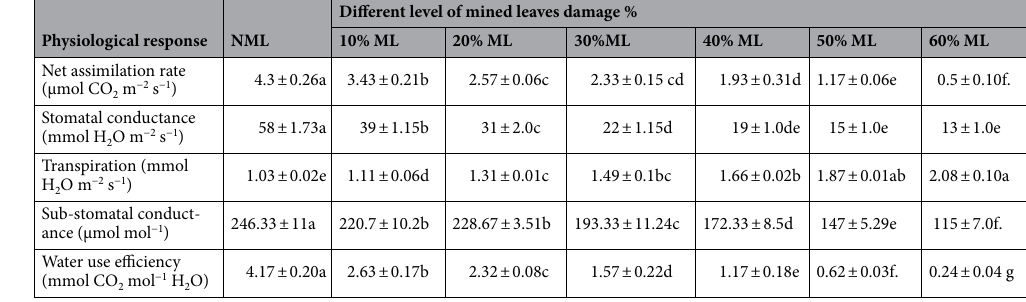
Table 12. Physiological responses of non-mined and mined leaves. NML = Non-mined leaves and ML = Mined leaves (10%,20%,30%,40%,50% and 60% damaged leaves) Results were reported in means (± SD). Means sharing dissimilar letters are significantly differed according to LSD test ( P ≤ 0.05) for non-mined and mined leaves different levels in Tables 8, 9 and 10.